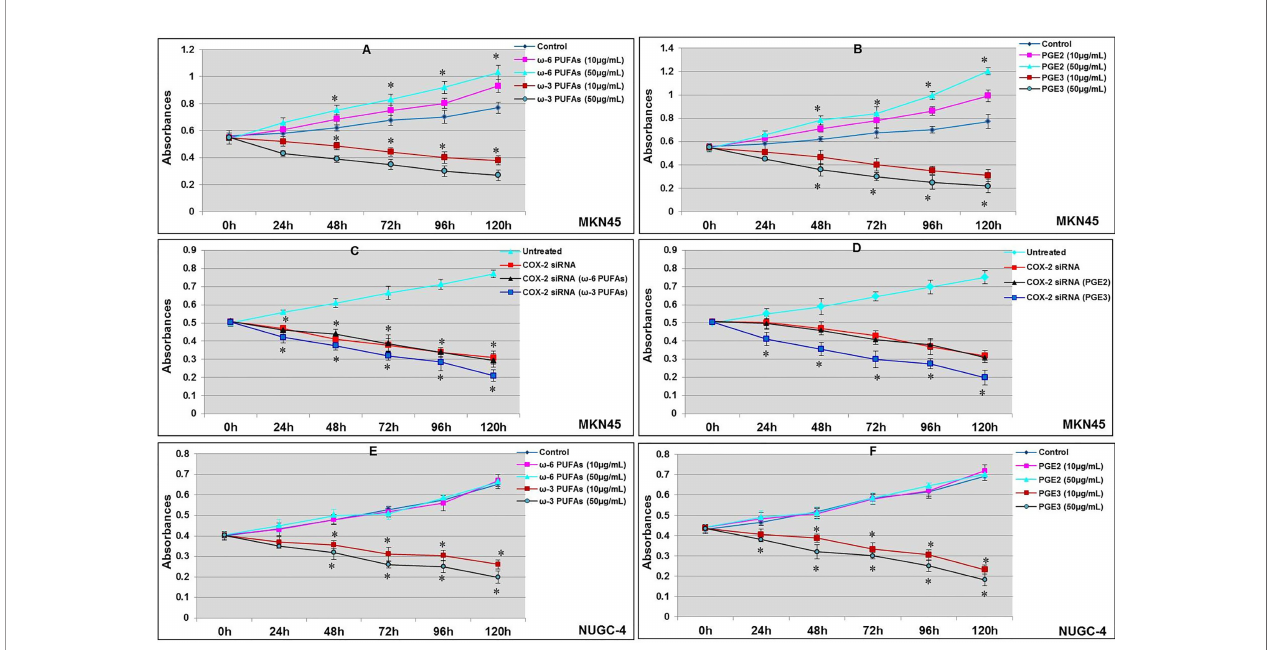
FIGURE 4 | Effects of w -3 PUFAs, w -6 PUFAs, PGE2, and PGE3 on proliferation of gastric cancer cell. MKN45 gastric cancer cells incubated for 24 h; the proliferation of cancer cells was measured by WST-1 assay. The proliferation of MKN45 cells in w -3 PUFA (A) and PGE3 (B) were signi fi cantly inhibited (compared with control groups, * p < 0.01); w -6 PUFAs (A) and PGE2 (B) signi fi cantly promoted the proliferation (compared with control groups, * p < 0.01). MKN45 cells were transfected with COX-2 siRNA; the proliferation of MKN45 cells were signi fi cantly inhibited (compared with control group, * p < 0.01). PGE3 and w -3 could also inhibit the proliferation of MKN45 (compared with COX-2 siRNA group, * p < 0.01). However, there were no signi fi cant changes in w -6 and PGE2 (C , D) . The proliferation of NUGC-4 cells was signi fi cantly inhibited by the presence of w -3 and PGE3. Moreover, there were no signi fi cant changes in the presence of w -6 and PGE2 (compared with the control groups, respectively, * p < 0.01, E , F ). Multiple comparisons used the method of one-way ANOVA and followed by the SNK test. Values are expressed as mean ± SD. Bars indicated SD, * p < 0.01. The experiments were performed at least